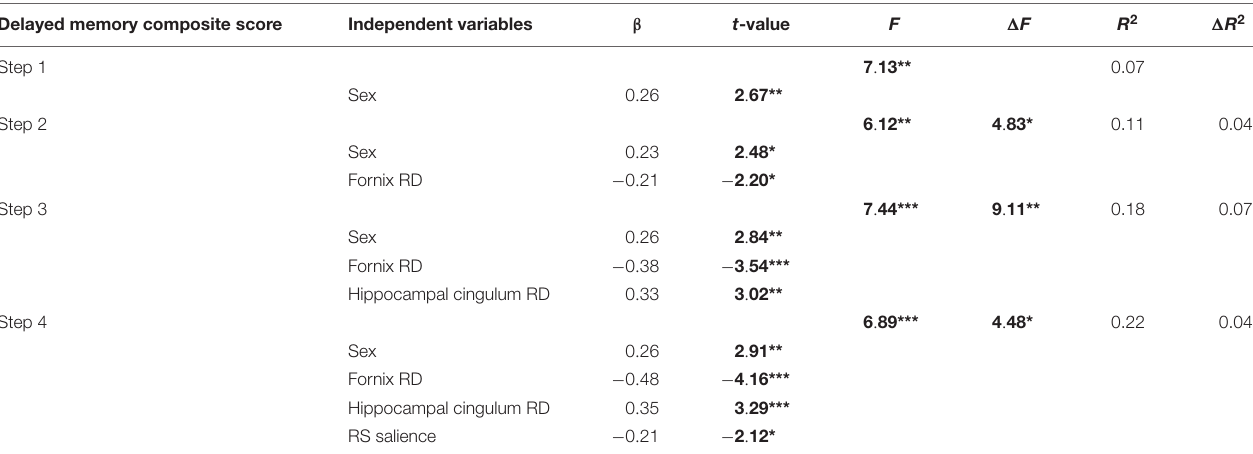
FIGURE 1 | Regression coefficient betas (absolute values) from the hierarchical linear regression plotted for variables of interest color coded based on entry into the regression. Error bars are 95% confidence intervals. Demographic variables were entered in Step 1, CSF measures were entered in Step 2, gray matter volumes were entered in Step 3, DTI measures were entered in Step 4, and functional connectivity measures were entered in Step 5. Fornix RD, hippocampal cingulum RD, and salience network resting state connectivity were significant predictors of delayed episodic memory performance. * p < 0.05; ** p < 0.01; *** p < 0.001. TABLE 3 | Stepwise regression explaining variability in delayed episodic memory